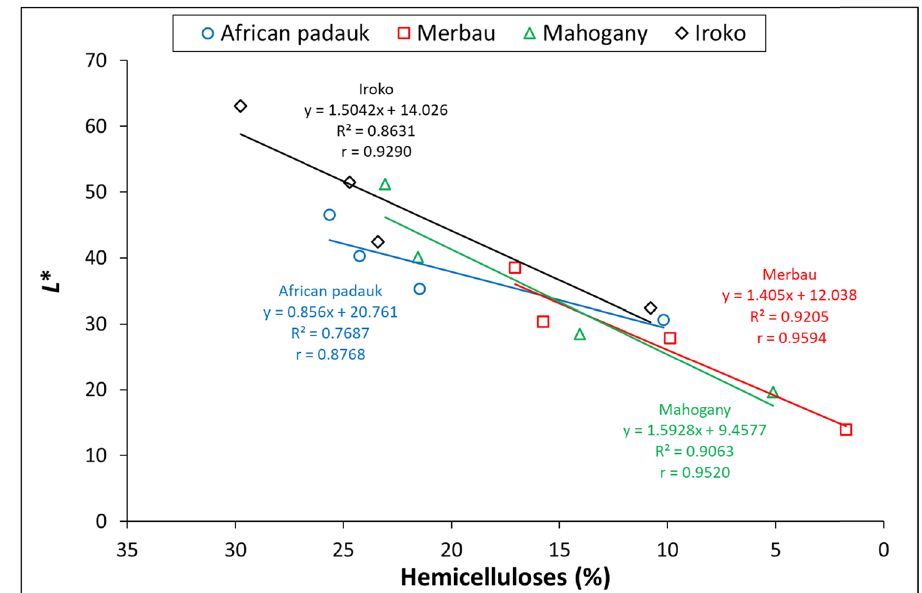
Figure 1: Dependence of the Δ L * on the degradation of the hemicelluloses.